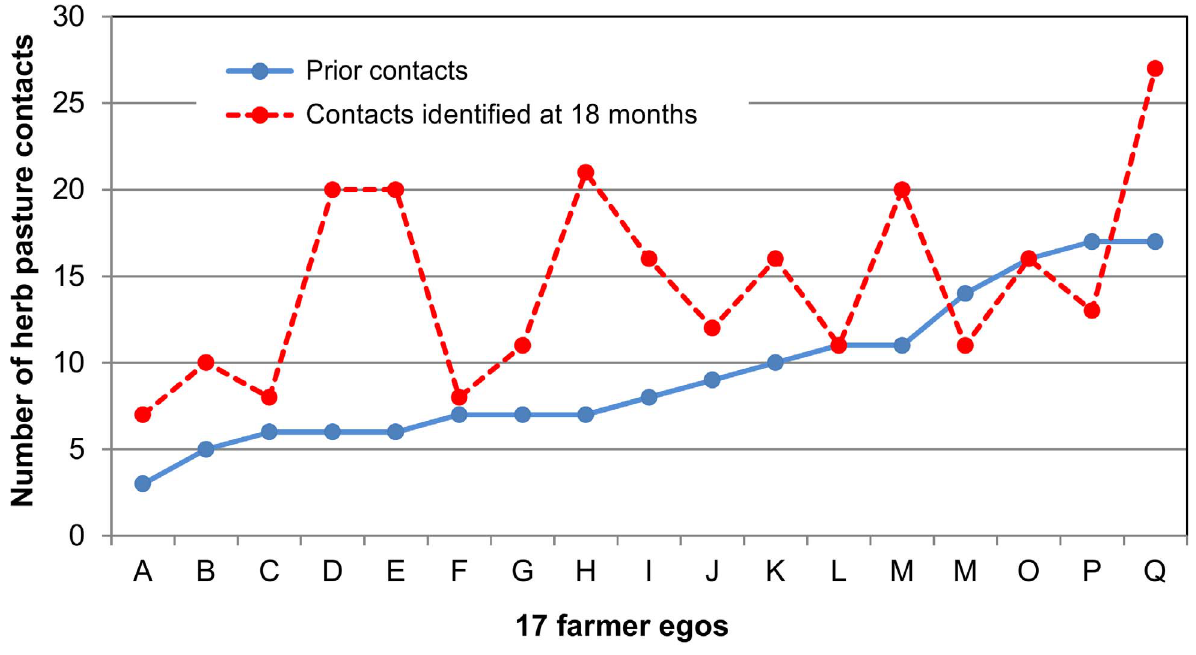
Figure 2. Degree distributions of the 17 farmers’ prior contacts and the contacts made after 18 months. Data is plotted by ascending size of the farmers’ prior contact networks.